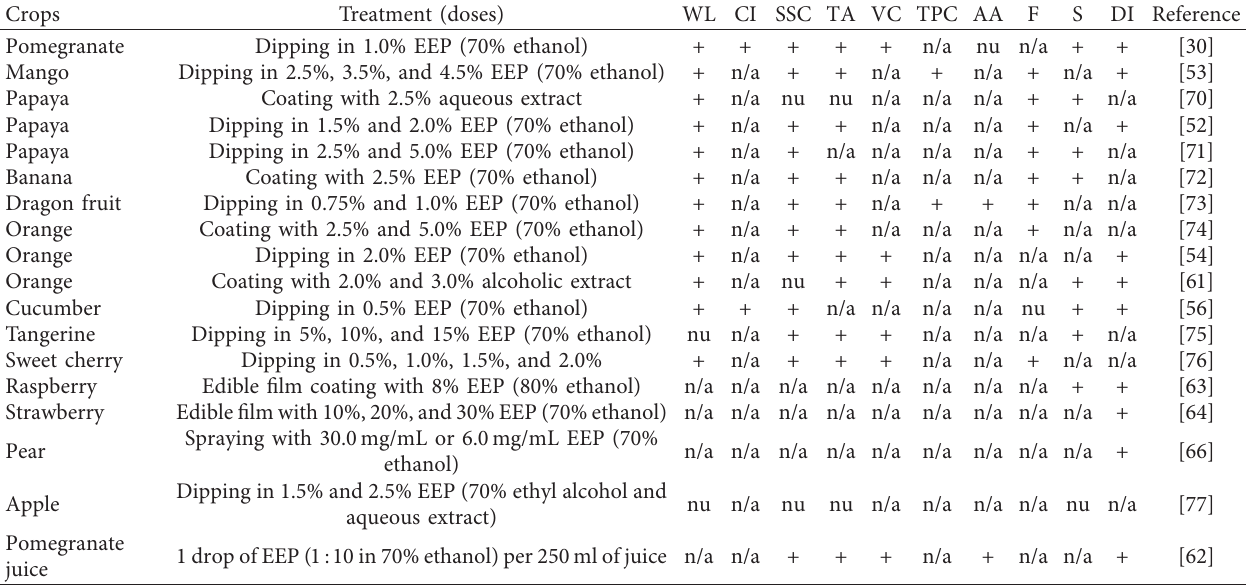
Table 2: Summary of the existing literature on the postharvest efficacy of propolis on food storability. Crops